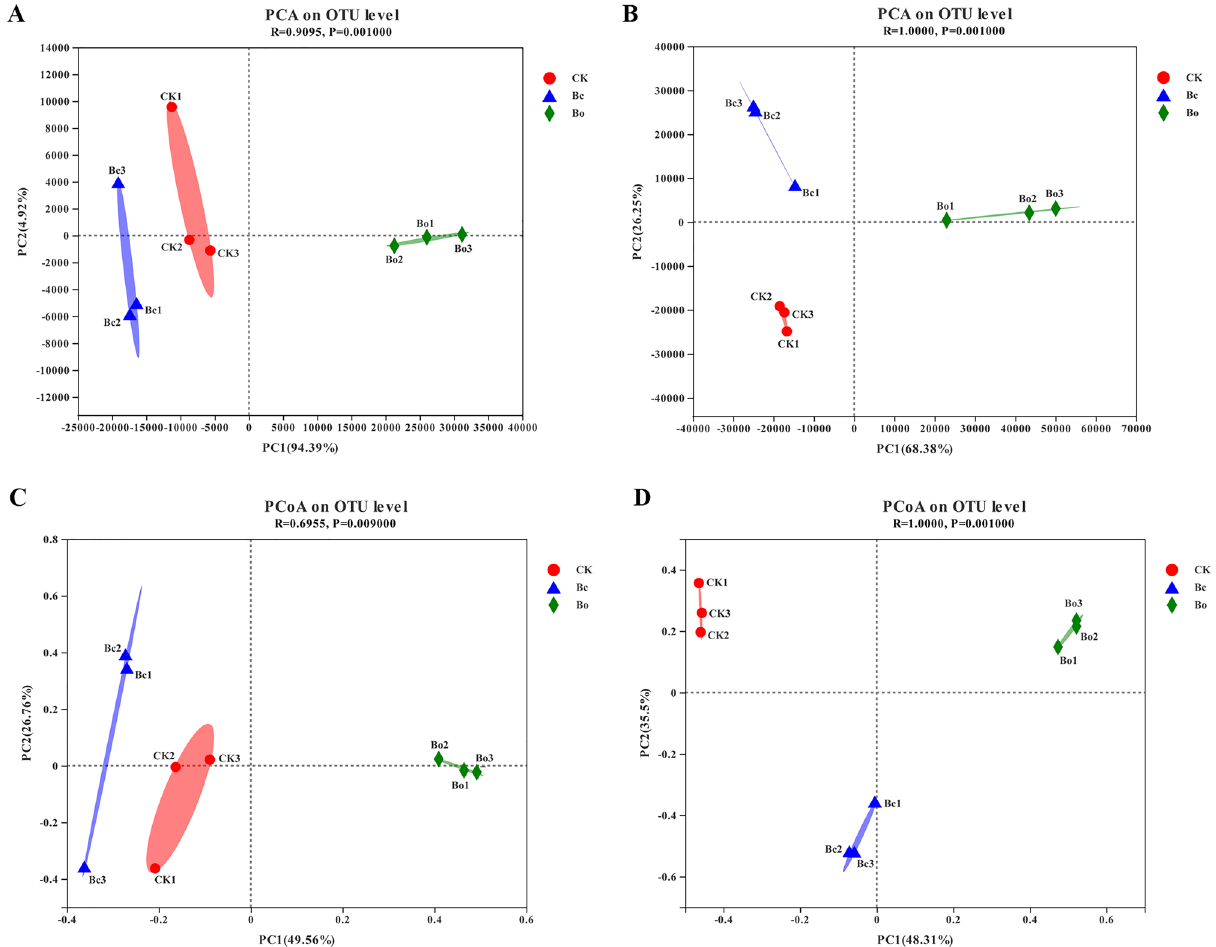
Figure 5. The results of PCA and PCoA analyses of OTUs in all the samples. ( A ) PCA for 16S rDNA data at the OUT level. ( B ) PCoA for 16S rDNA data at the OUT level. ( C ) PCA for ITS data at the OUT level. ( D ) PCoA for ITS data at the OUT level. CK: the group fed on an artificial diet, Bc : the group fed on B. campestris; Bo : the group fed on B. oleracea. The figure was created by R project Vegan package (version 2.4–3) (https:// github. com/ vegan devs/ vegan/ relea ses/ tag/